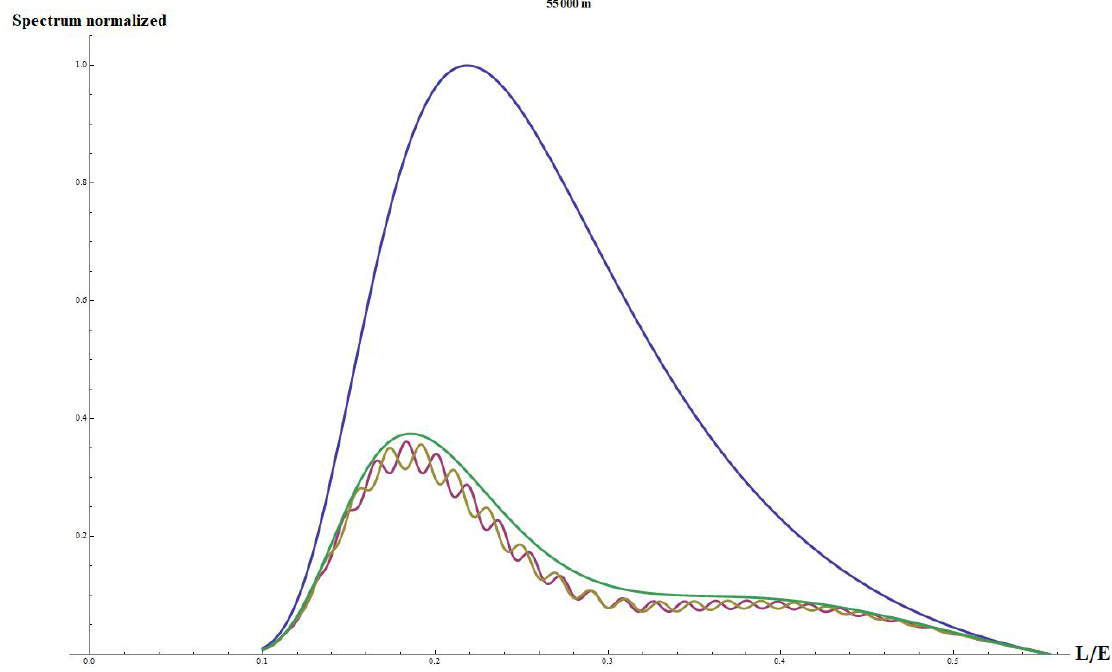
Figure 14. JUNO experiment modified spectrum by LIV, with δ f 32 = 10 − 23 and δ f 21 = 10 − 25 , plotted as a function of the variable L/E, for fixed baseline L=55km. In this plot there are no visible differences with respect to the previous